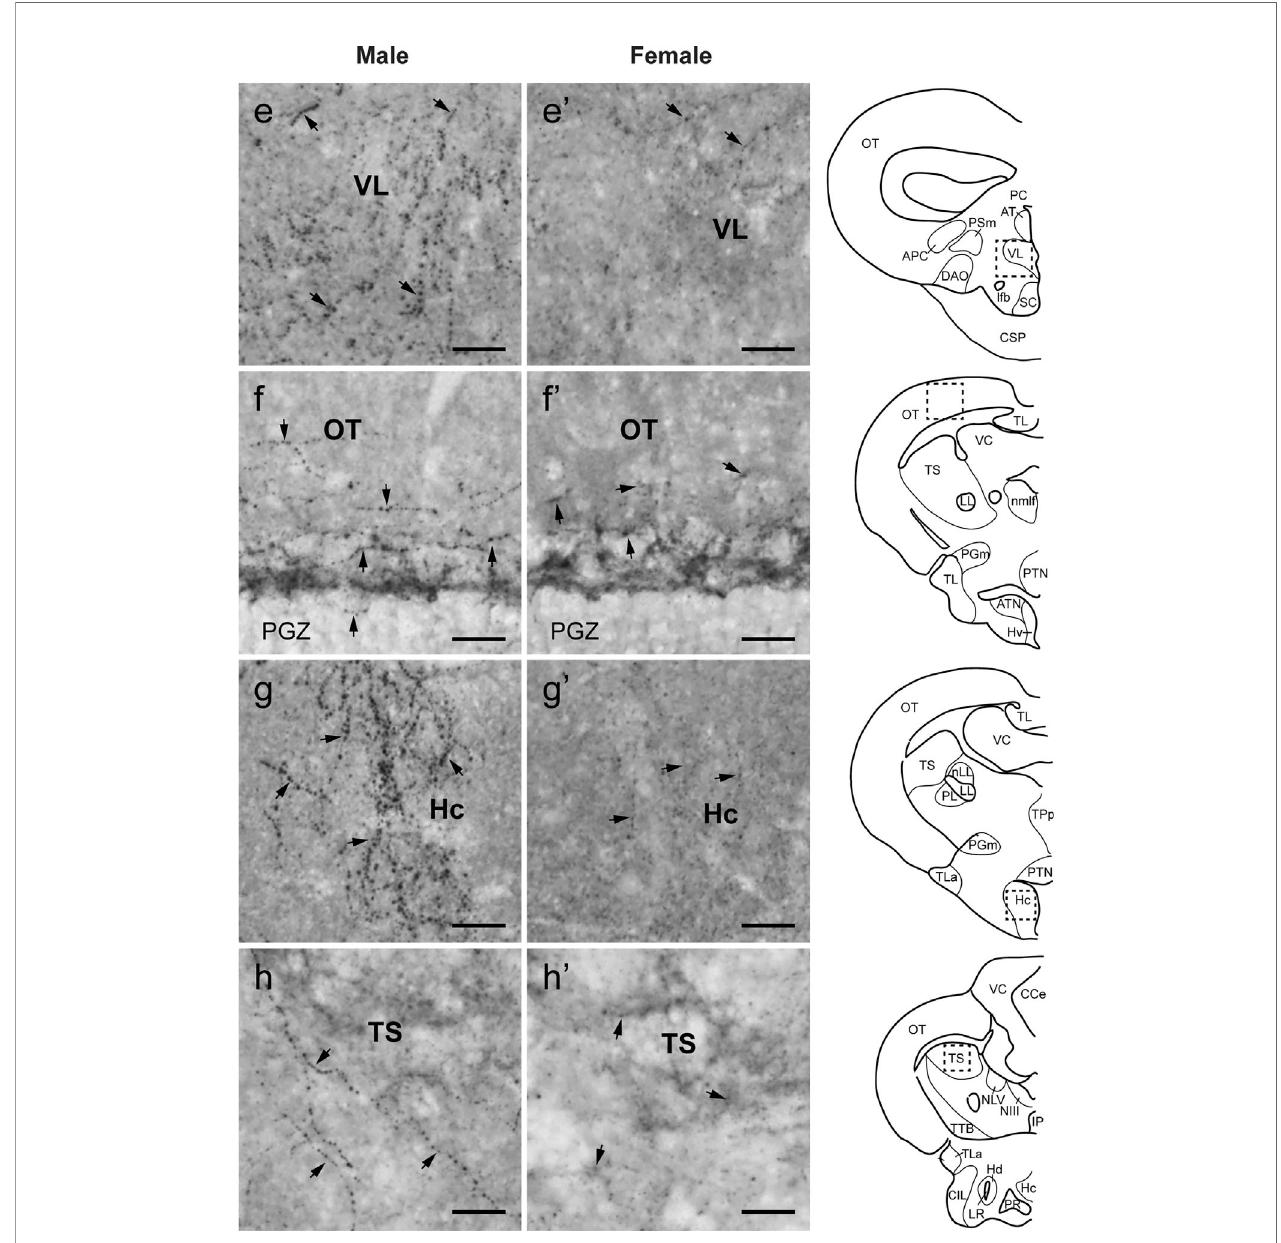
FIGURE 6 | Comparison of Tac1-immunoreactive processes in the diencephalic and mesencephalic regions. Left (E − H) and middle (E ’ − H ’ ) columns represent photomicrographs of Tac1-immunoreactive processes (arrows) in the brain of males and females, respectively. Boxes with a dotted line in the schematic drawing of coronal view in the right column indicate the localization of the boundaries of the respective immunohistochemical illustrations. In some diencephalic nuclei, more Tac1-immunoreactive processes are seen in male brains (E , G) as compared to females (E ’ , G ’ ) . In the mesencephalic nucleus, densities of Tac1-immunoreactive processes were slightly higher in males (F , H) as compared to females (F ’ , H ’ ) . Scale bars: 20 µm. See Glossary for